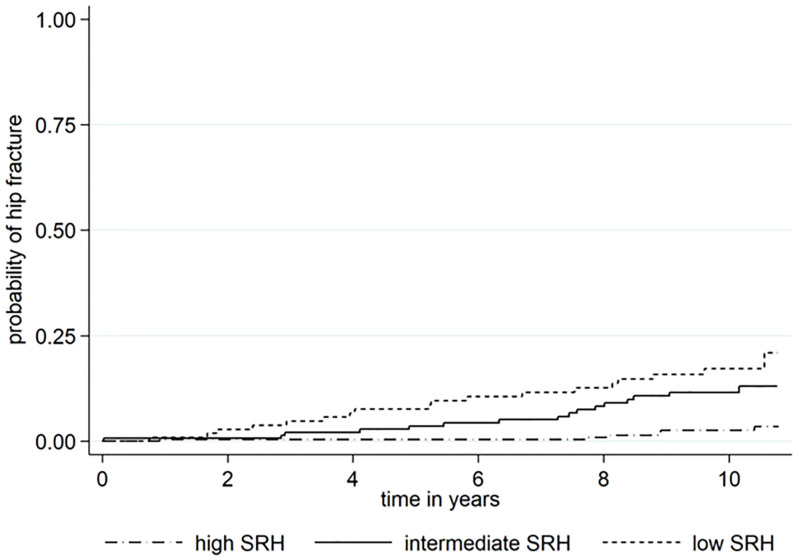
Kaplan Meier failure estimates for age 72.4 years (median age in the cohort).